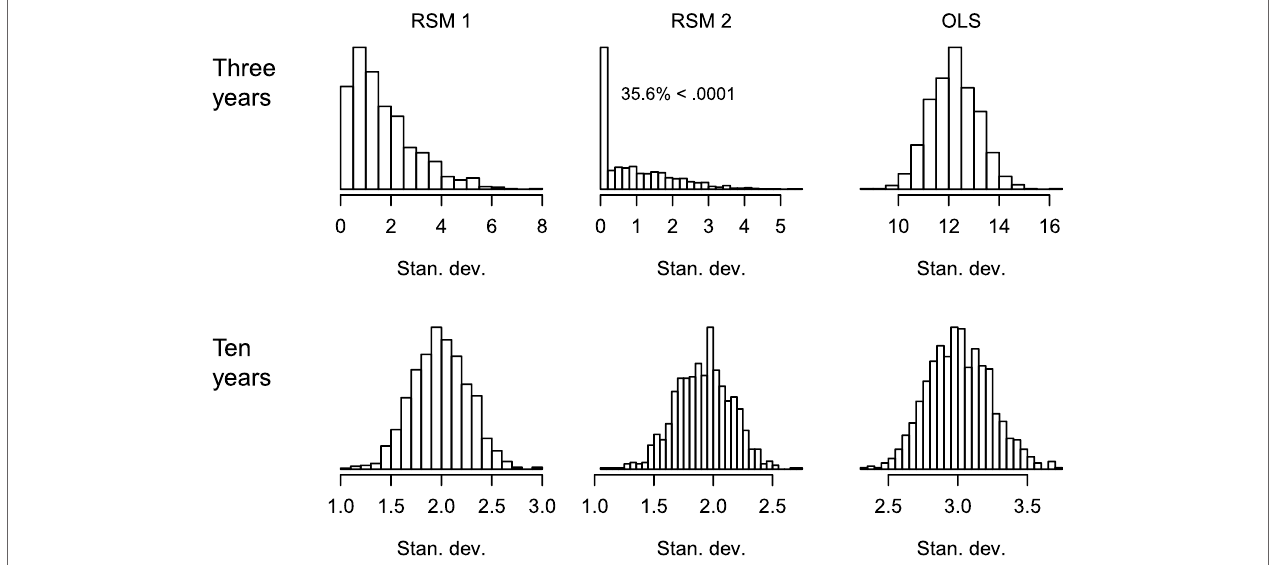
FIGURe 6 | Histograms of the SDs of the slope estimates for the different estimation methods when there are 3 and 10 years of data. Simulation 2 (negatively skewed). RSM 1 and RSM 2 refer to estimating the correlation between the random variables (1) and fixing it at zero